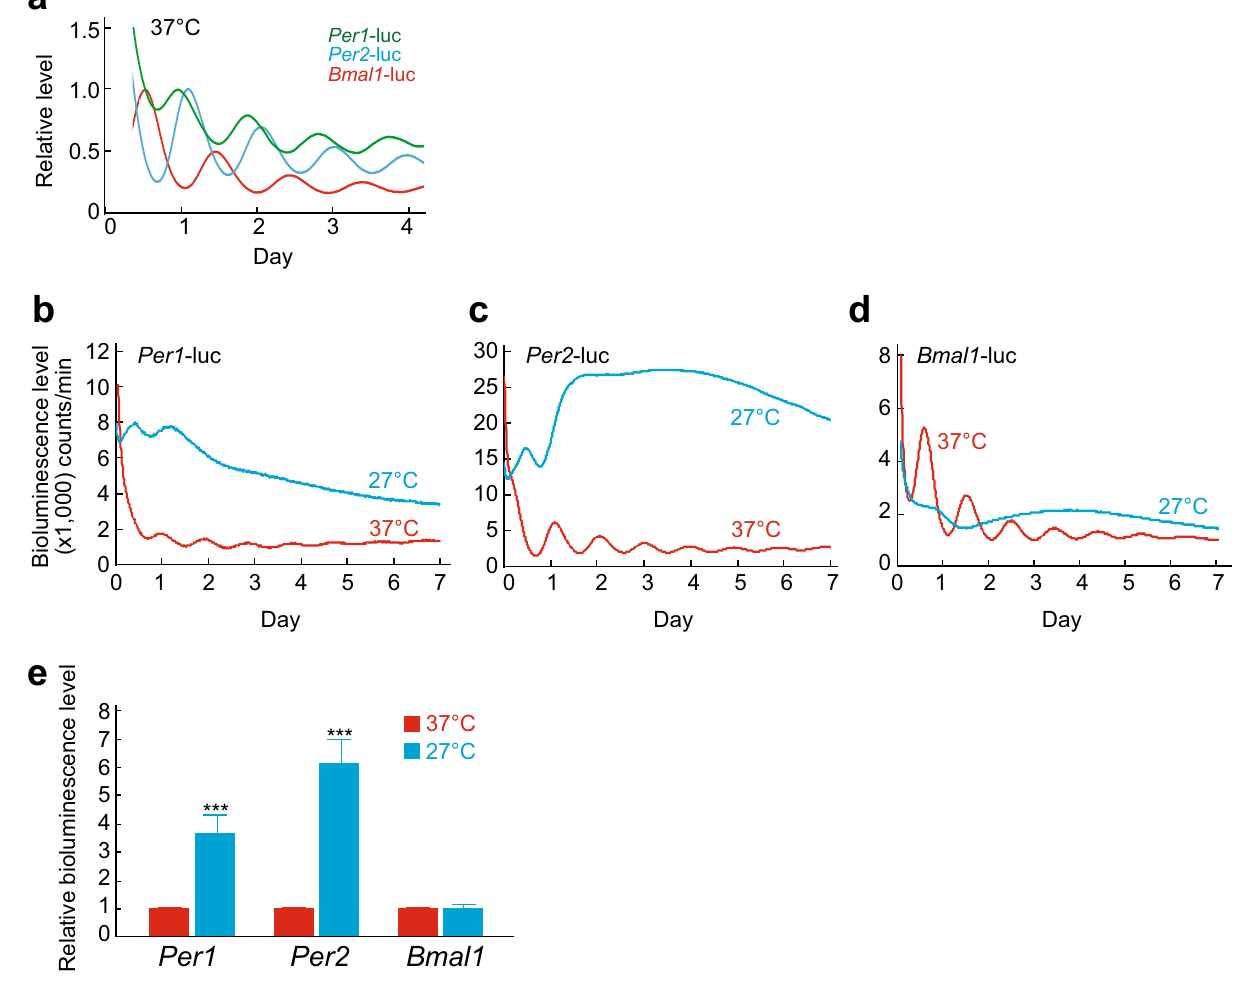
Figure 2. Effects of temperature on transcriptional reporters of clock genes. ( a ) Representative bioluminescence rhythms driven by Per1 -luc, Per2 -luc, or Bmal1 -luc reporter. The first peak is normalized to 1 in the vertical axis. The rhythms were smoothing by 1-h centered moving average for clearness to compare the phase of each reporter. Representative data of bioluminescence rhythms of Per1 -luc ( b ), Per2 -luc ( c ), and Bmal1 -luc ( d ) at 37 °C or 27 °C. ( e ) Relative bioluminescence levels of Per1, Per2 , or Bmal1 calculated by the area under the curve (AUC) from Day 0 to Day 3. The means of AUC at 37 °C were set to 1 in vertical axis. Mean with s.e.m. from 4 independent samples are shown. *** p < 0.001 compared to the data at 37 °C (Student’s